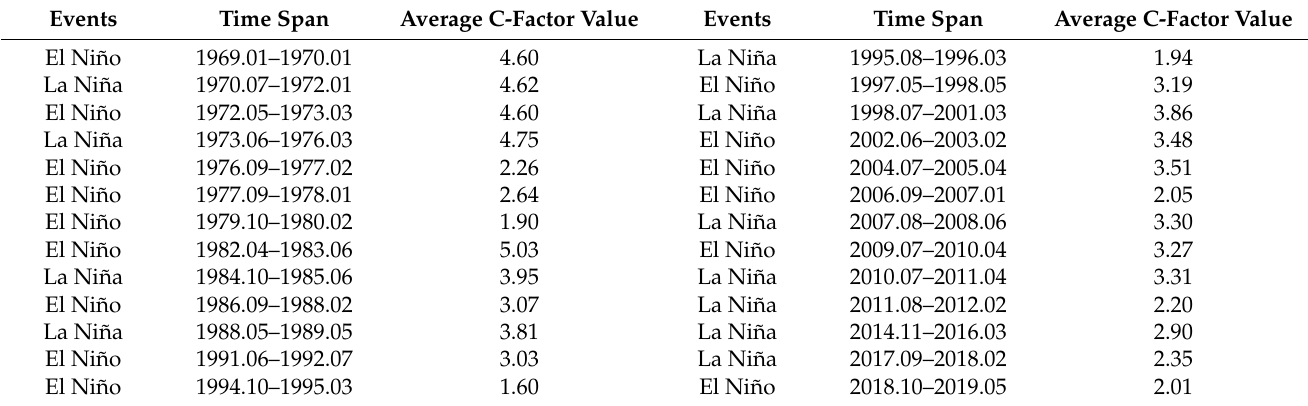
Table 2. Average monthly climatic erosivity during El Niño and La Niña events (50